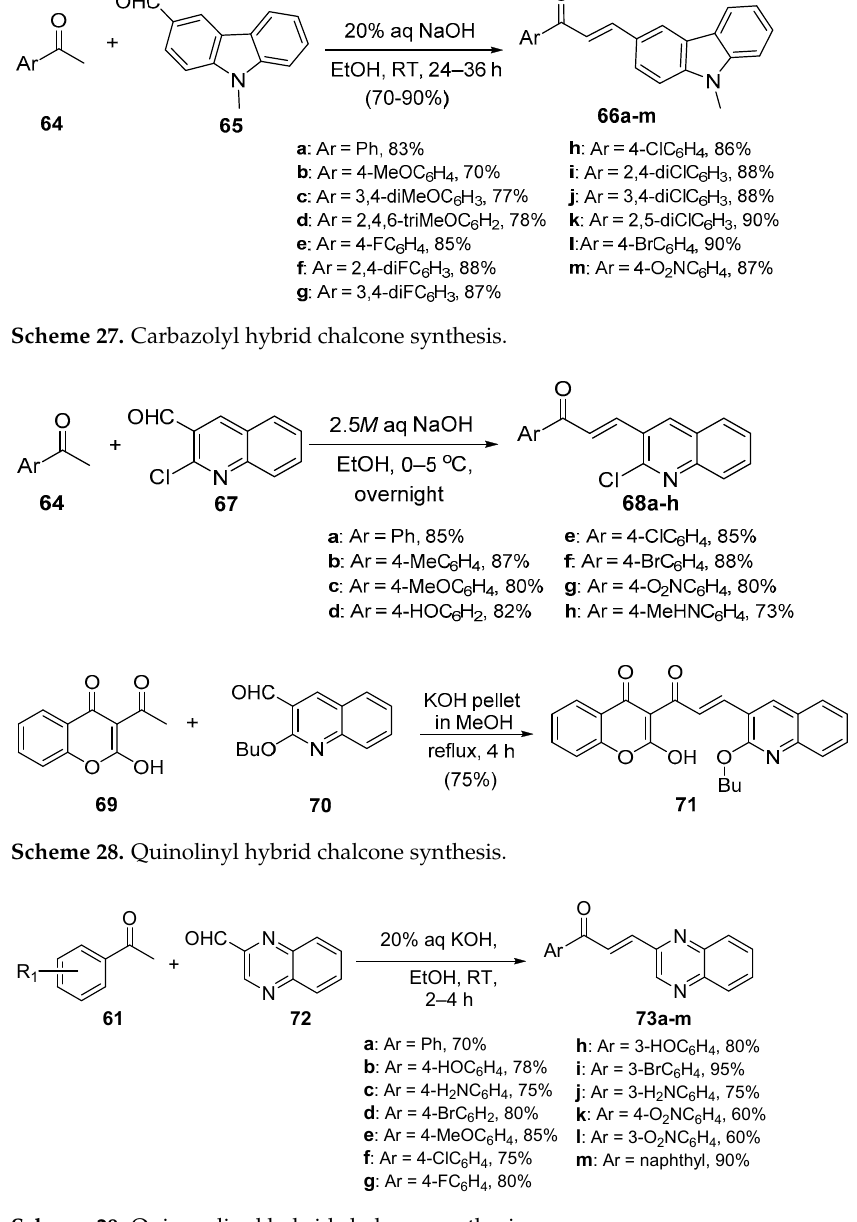
Figure 4. Hybrid chalcone heteroaromatic components prepared by Sun et